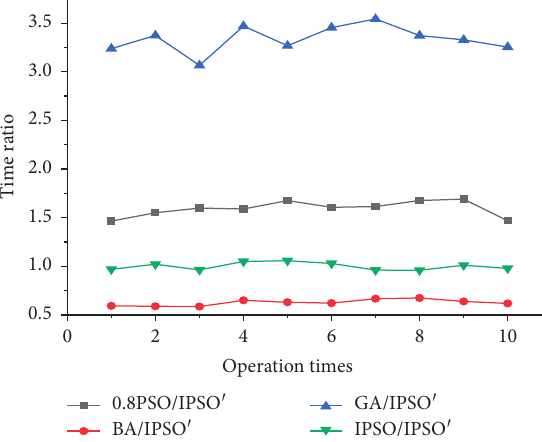
Figure 12: Ratios of running time of the four